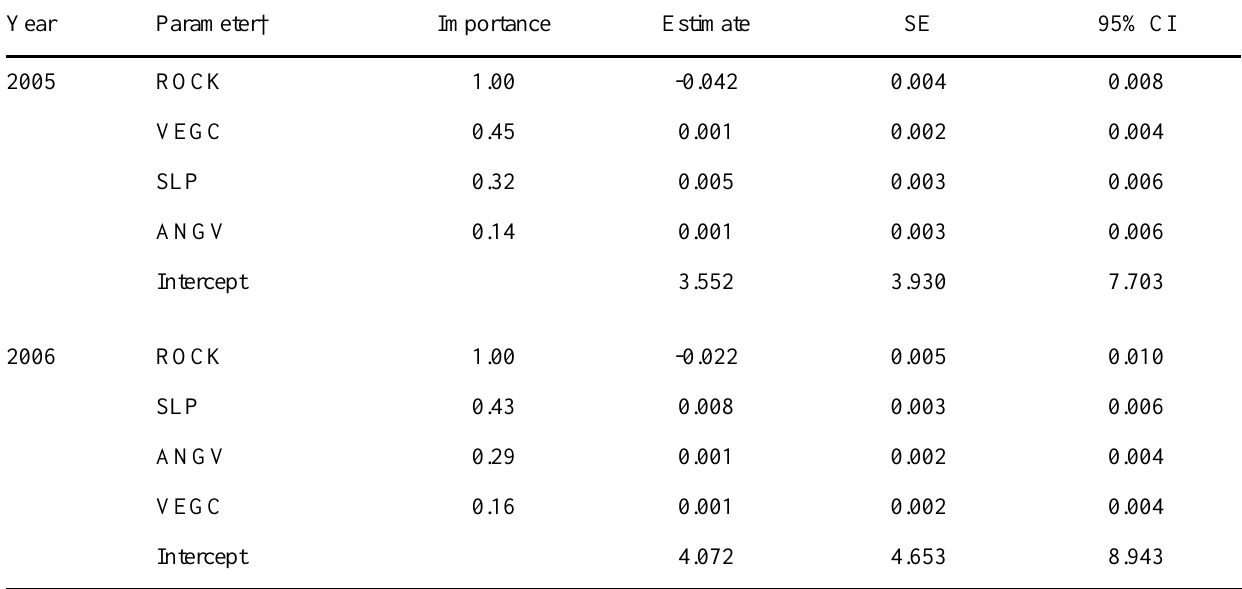
Table 4 . Importance values, model-averaged parameter estimates, and associated unconditional standard errors (SE) and 95% confidence intervals (CI) for parameters explaining mean temperature in Fork-tailed Storm-Petrel ( Oceanodroma furcata ) nests at Kasatochi Island, Alaska. Parameters are listed in order of importance for each year based on importance values; only those appearing in competing models ( D AIC < 2.0) are